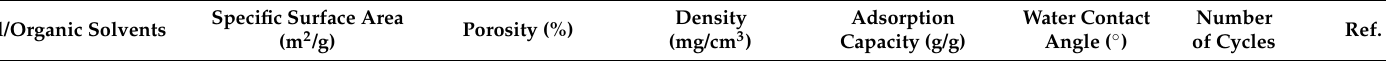
Table 7. Performance of nanocellulose-based aerogels compared with chitosan-based aerogels for oil/organic solvent separation. PNI-Si@CCNT/CA: vinyltrimethoxysilane and thermally responsive poly(N-isopropylacrylamide) (PNIPAAm) were grafted onto the surface of a carboxylated carbon nanotube/chitosan aerogel backbone to obtain aerogels; CA/CS/CMC: citric acid/chitosan/carboxymethyl cellulose aerogel; DMF: dimethylformamide; THF: tetrahydrofuran; DMSO: dimethyl sulfoxide; DCM: